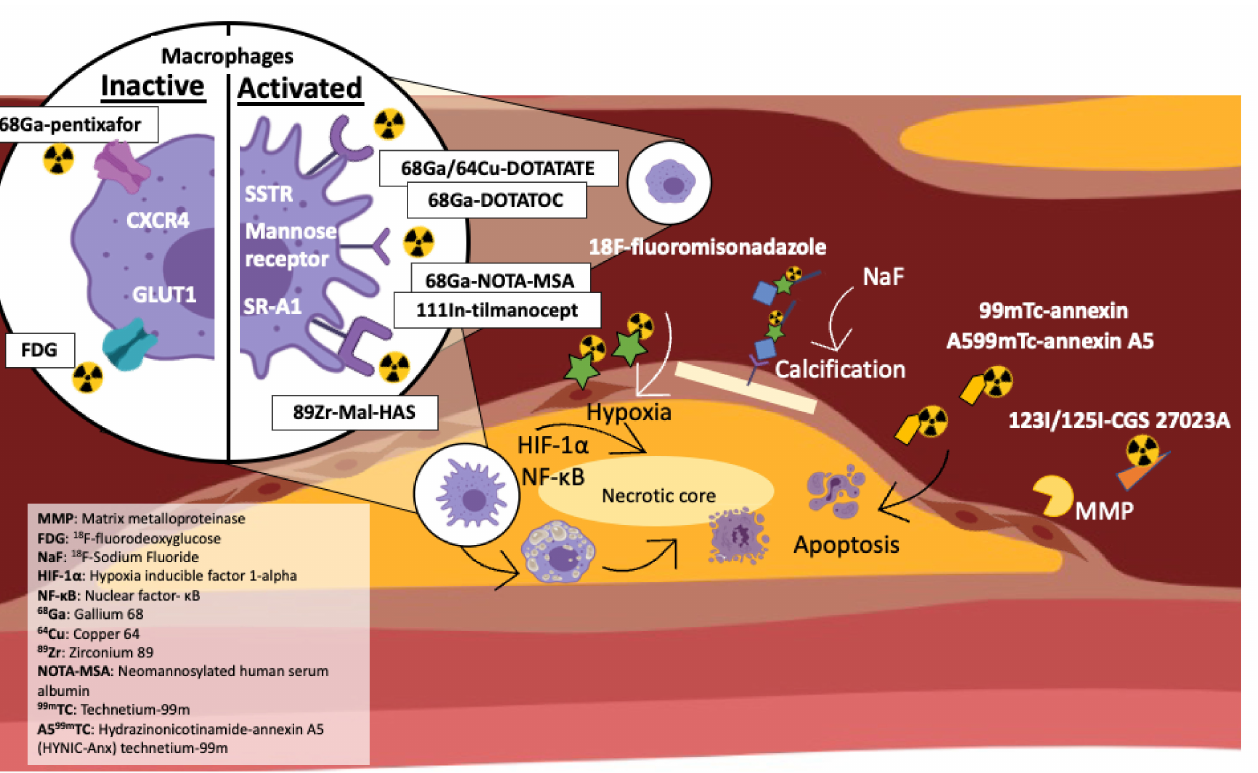
Figure 1. Schematic representation of pathophysiological pathways and the radiotracers that can image them. FDG is taken up by high metabolically active cells (i.e., inflammatory cells including macrophages). NaF targets micro- and macro-calcification and is typically used to identify vulnerable plaque. 123l/125l-CGS 27023A targets MMP plaque activity, associated with plaque vulnerability. 18 F-fluoromisonadazole targets hypoxia. 99mTc-annexin and A599mTc-annexin A5 target cell apoptosis. 68Ga/64Cu-Dotatate, 68Ga-DOTATOC, 68Ga-NOTA-MSA, 111In-tilmanocept and 89Zr-Mal-HAS target activated macrophages. 68Ga-pentixafor targets macrophages and